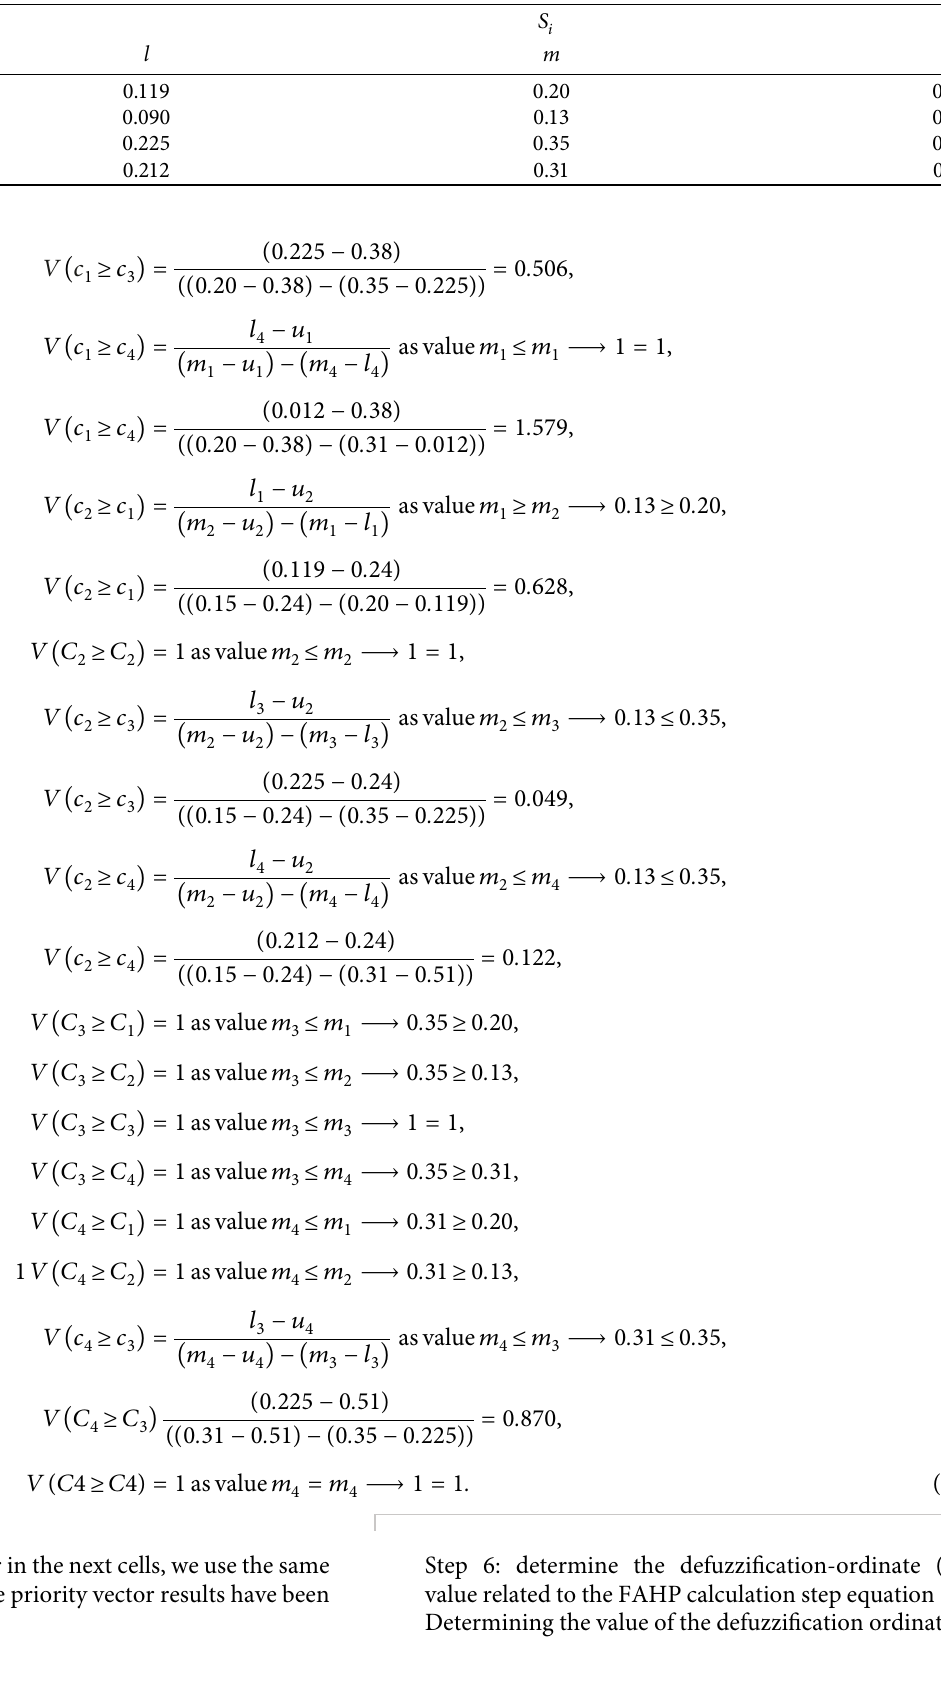
Table 7: Synthesis value